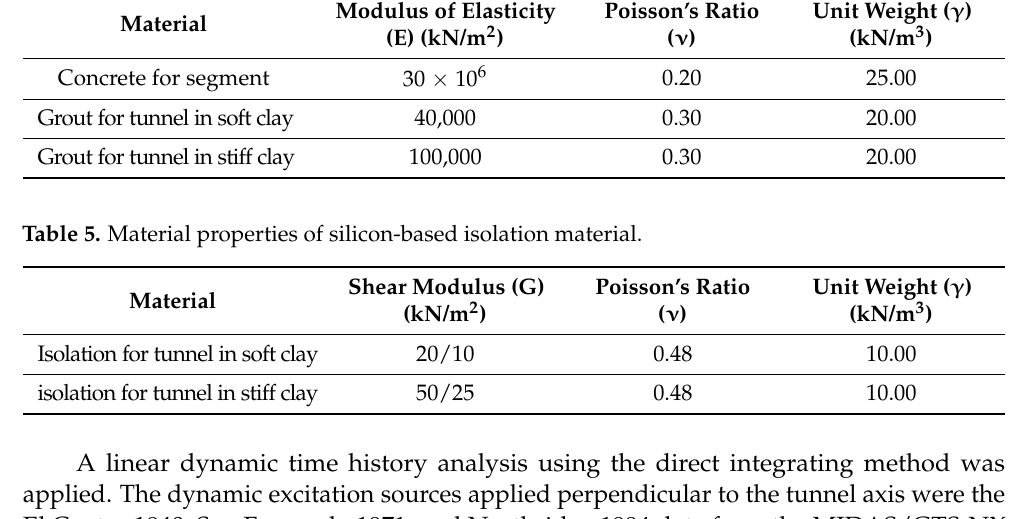
Figure 10. Numerical modeling development flowchart. 4. Results and Discussion The effects of using isolation on the tunnel’s vertical displacement (settlement or heave) are currently being examined. This study focuses on the final displacement of the tunnels and their induced stresses in the transverse direction, where the tunnels are struc ‐ tures that resist movement in the transverse direction. According to the European design code, the principal compression and tension stresses and the allowable stress are equal to 400 kN/m 2 , leading to allowable tensile stress of 3200 kN/m 2 and compression stress of 23,000 kN/m 2 . The three earthquake time histories used in this study are thought to be accurate for actual design work because they get the best response.